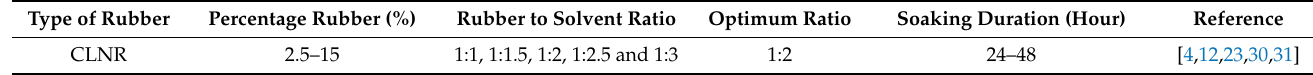
Table 1. Toluene application method based on previous studies.